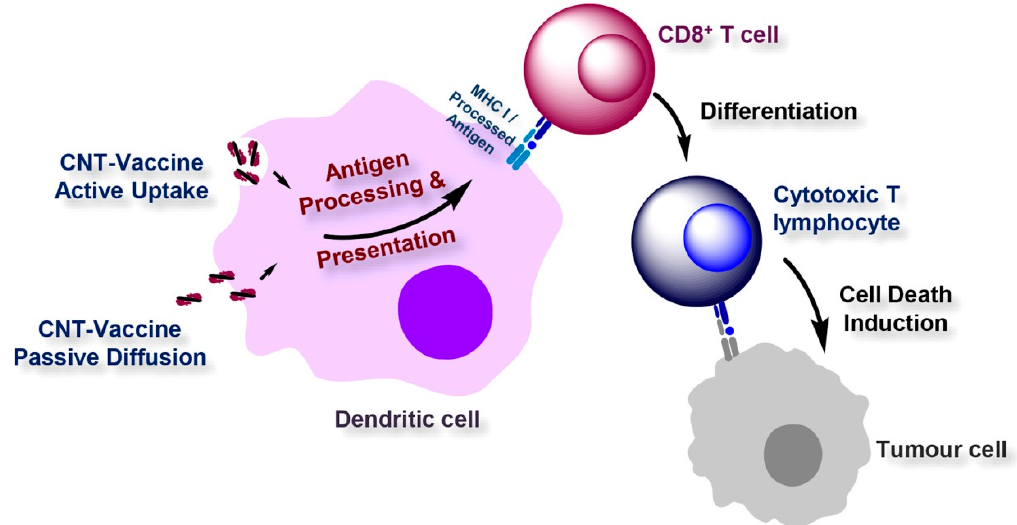
Figure 7. Proposed pathways for MHC presentation of CNT-delivered antigens. CNTs could deliver the incorporated antigen to the cytosol of the DCs via two proposed routes, where degradation by the proteasome and subsequent MHC class I presentation occur. The ability of CNT-antigen conjugates to passively diffuse through the cell membrane could directly deliver the loaded antigen to the cytosol. Alternatively, following the active uptake of CNT-antigen conjugates by DCs and the subsequent endosomal escape, the incorporated antigen could gain entry into the cytosol. In addition, to overcome the need for endosomal escape, antigenic fragments yielded from antigens processed in the endosomes by endosomal proteases could be loaded onto the MHC class I molecules recycled from the plasma membrane. Furthermore, professional cross-priming DCs could translocate the endocytosed antigenic cargo to the MHC class I pathway via the utilization of a cross-presentation mechanism. Lysosomal degradation of CNT-delivered antigens that fail to escape the endosomes could be followed by MHC class II presentation. (Reproduced with permission from Ref. [78]).